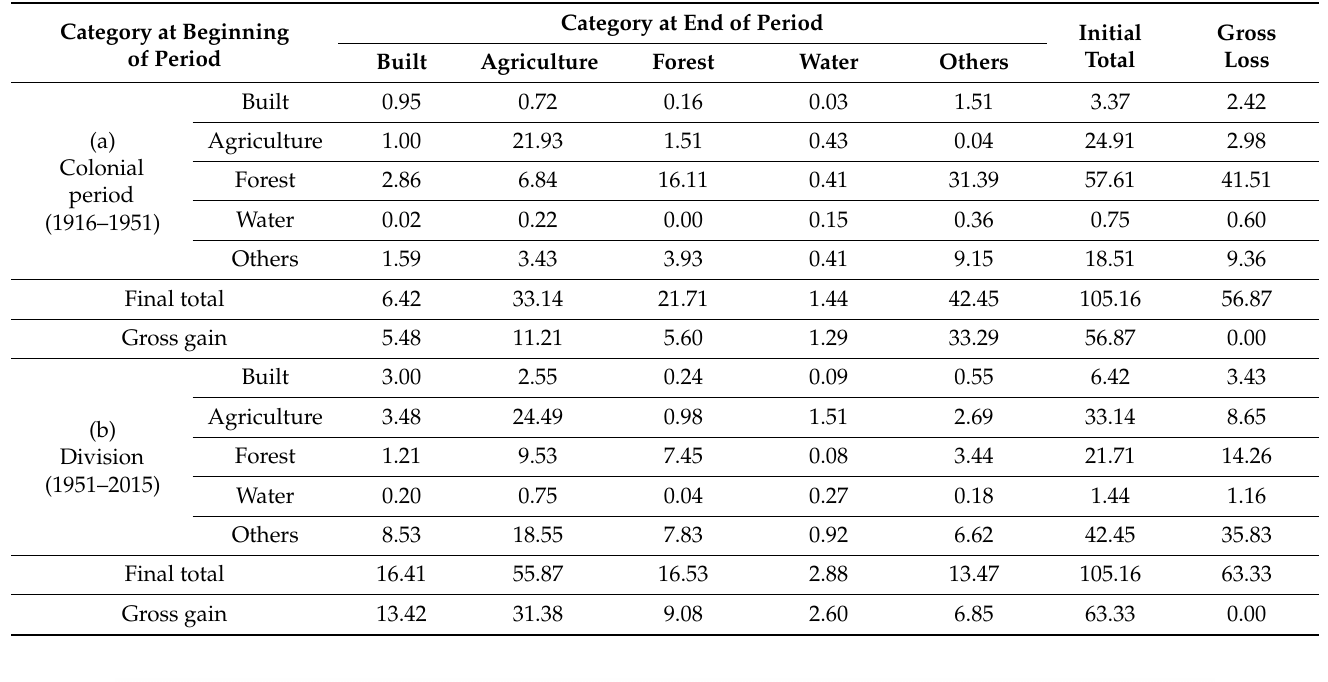
Table 1. Crosstabulation of land-use and land-cover changes (LUCCs) in square kilometers during: